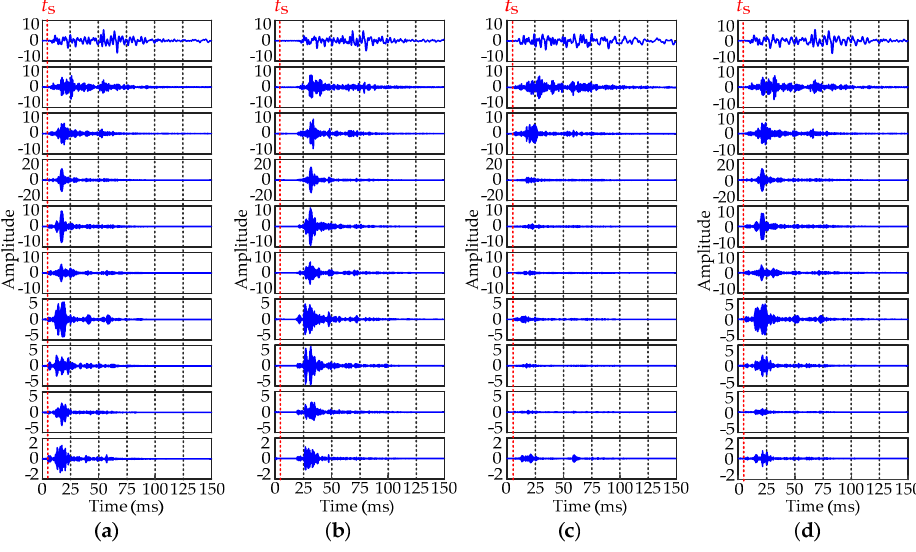
Figure 10. IMFs of the four types of vibration signals obtained by VMD. ( a ) Normal condition; ( b ) Fault I; ( c ) Fault II; ( d ) Fault III.